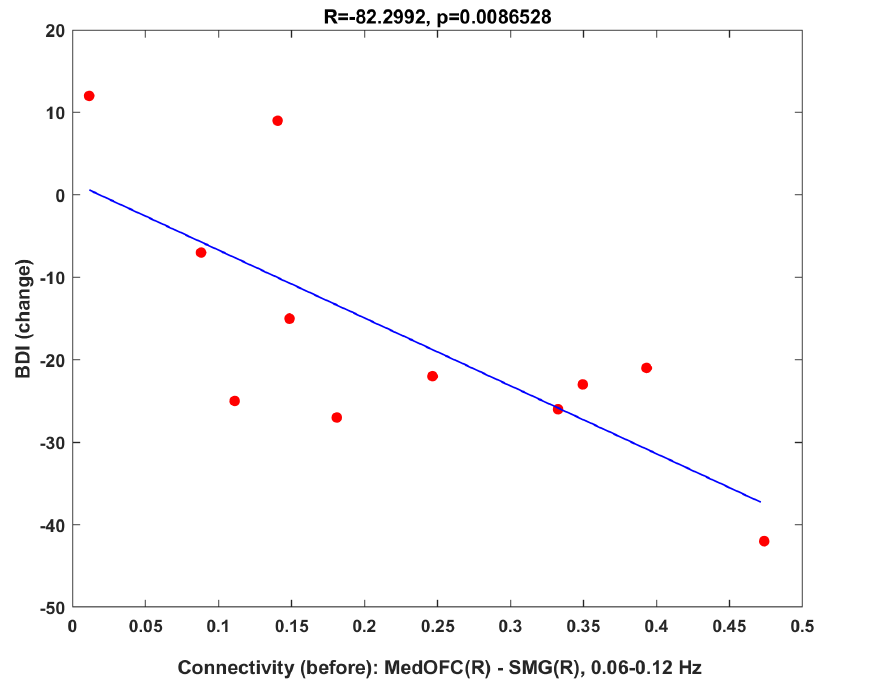
Figure 8. Scatter plot shows correlation between improvement in BDI score and baseline functional connectivity on connection between right medial orbitalfrontal cortex and right supramarginal gyrus in the 0.06–0.12 Hz band (coefficient R = − 82.2992 and its p -value = 0.0086528). Age, gender, and IQ were partialed out. One subject who could not finish the after-treatment clinical assessment is excluded from the